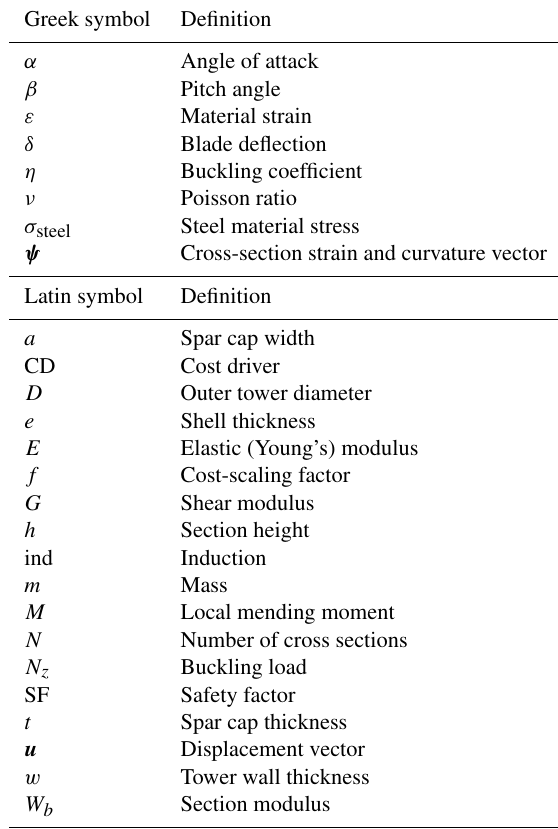
Table A1. List of symbols used in the